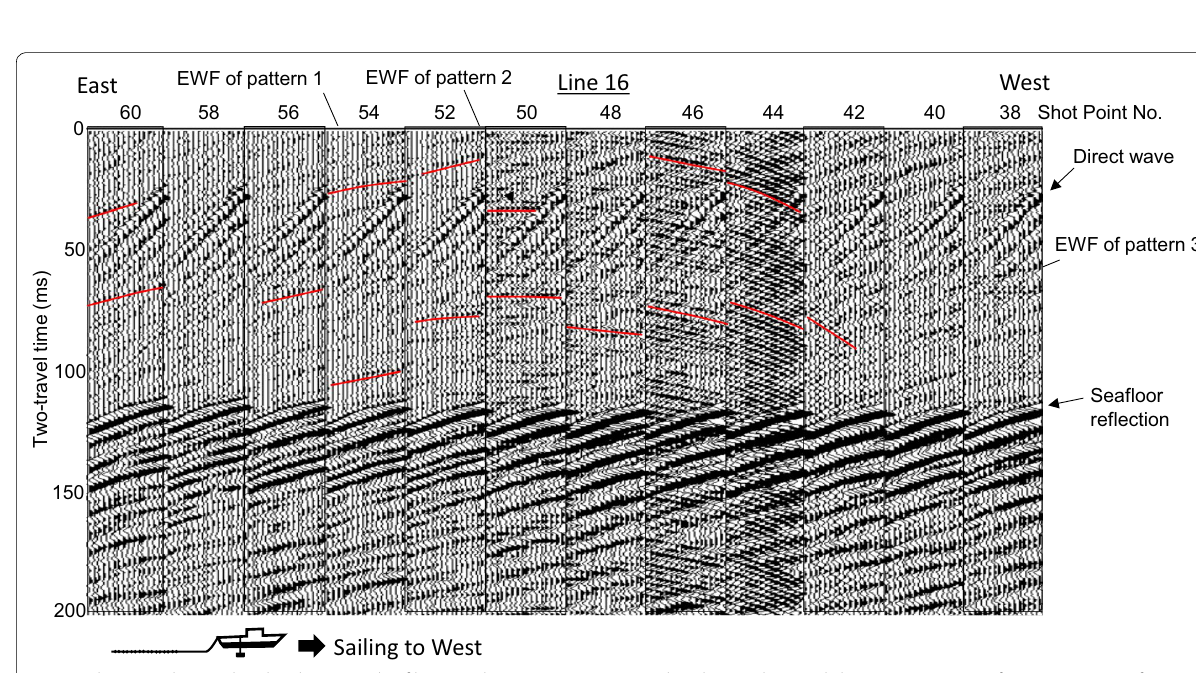
Fig. 9 The EWF observed in the shot records of line 16. Three EWF patterns can be observed around shot point 50: EWF of pattern 1, EWF of pattern 2, and EWF of pattern 3. The survey boat sailed toward the west on this